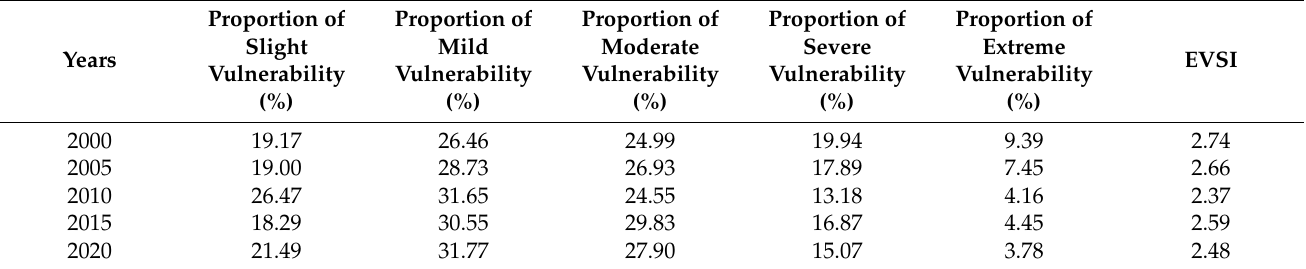
Table 3. Ecological vulnerability assessment of red soil erosion area in Changting from 2000 to